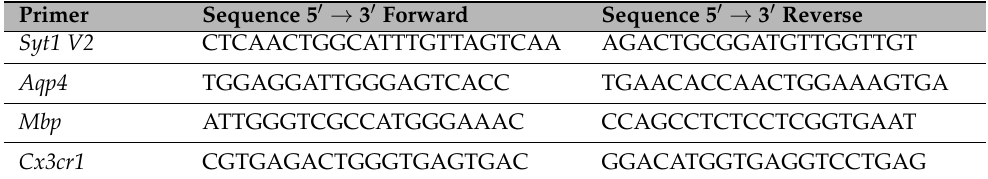
Table 1. Primers used for RT-PCR to check the purity of sorted microglia. Primer Sequence 5 (cid:48) → 3 (cid:48)